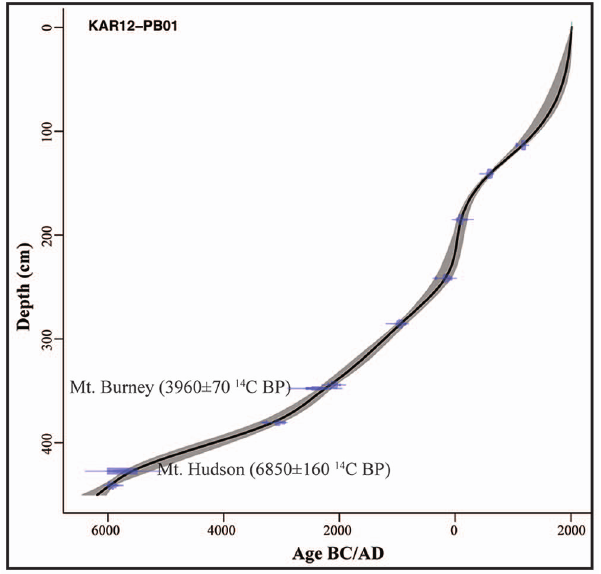
Figure 2. Age-depth model for the Karukinka peat core. Maximum likelihood ages are expressed in years Anno Domini (AD) and Before Christ (BC). The Hudson and Burney tephras are also used as chronological